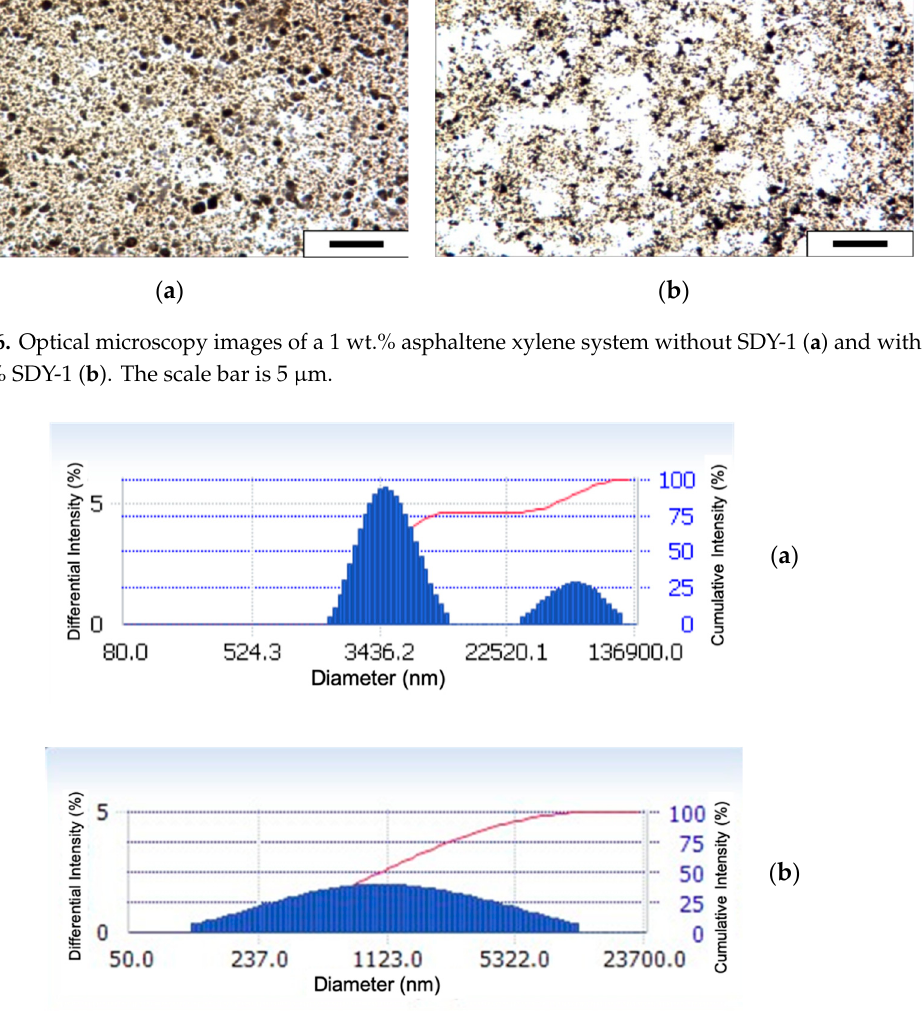
Figure 7. Asphaltene particle size distribution of the 1 wt.% asphaltene xylene system. ( a ) Without SDY-1 and ( b ) with 0.1 wt.% SDY-1.